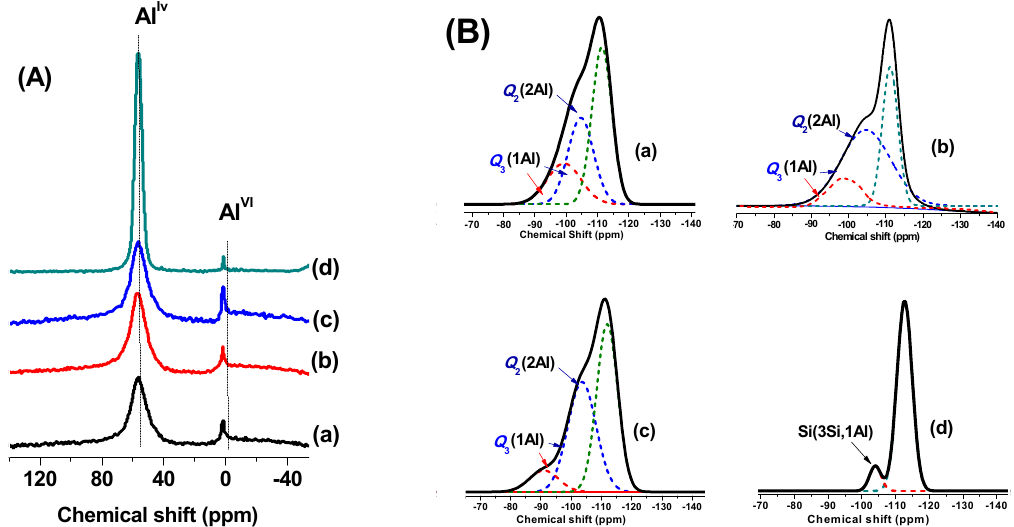
Figure 5. ( A ) 27 Al MAS NMR and ( B ) deconvoluted 29 Si MAS NMR of ( a ) MFI-40, ( b ) MFI-45, ( c ) MFI-50, and ( d ) Zeolyst samples.